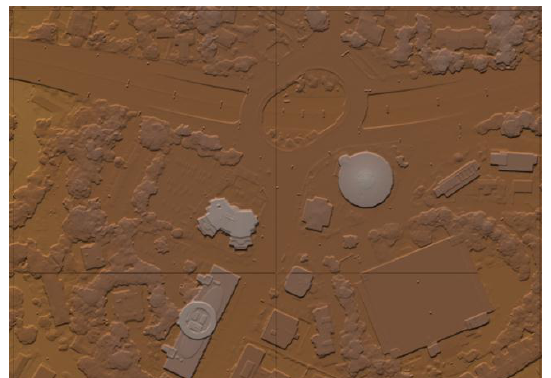
Figure 5 On-the-fly relief shading of a generated DSM which is one feature of the DragonFly technology (data courtesy of Ordnance Survey,